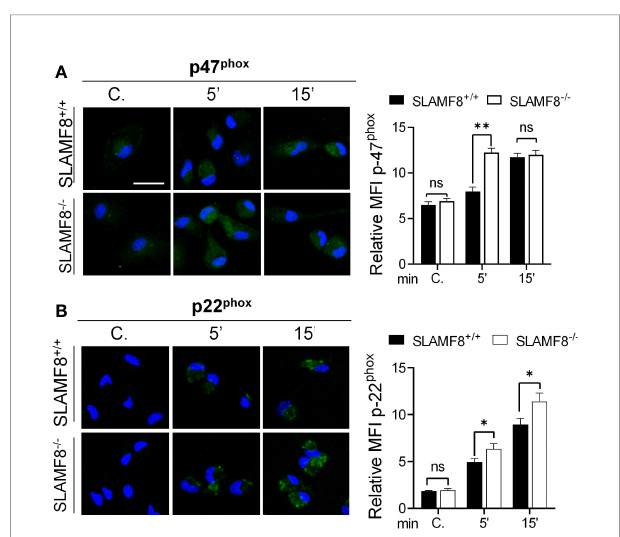
FIGURE 3 | Increased fl uorescence intensity staining of p47 phox and p22 phox in SLAMF8 -/- pMø indicates enhanced NOX subunit assembly compared to SLAMF8 -/- pMø. Immuno fl uorescence analysis of p47 phox and p22 phox in SLAMF8 +/+ and SLAMF8 -/- pMø activated with PMA and stained with the indicated antibody. Representative images of pMø treated with PMA at different time points and stained with a -p47 phox (A) or a -p22 phox (B) (green). Cell nuclei were stained with DAPI, and the samples were analyzed by confocal microscopy. Scale bar: 20 µm. The mean fl uorescence intensity (MFI) was measured as mean gray value (MFI) of maximum projection images and is graphically represented. Values indicate mean (maximum projection) ± SEM ( n = 50 stochastic cells per coverslip). Results of one representative experiment out of two independent experiments are shown. * p < 0.05; ** p < 0.001. C, control. ns, Not Signi fi cant.